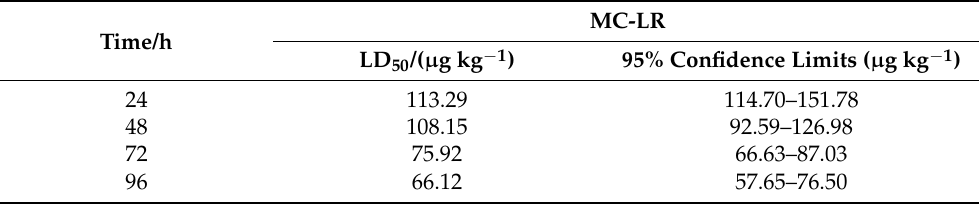
Table 4. The LD 50 s of MC-LR to Cherax quadricarinatus .